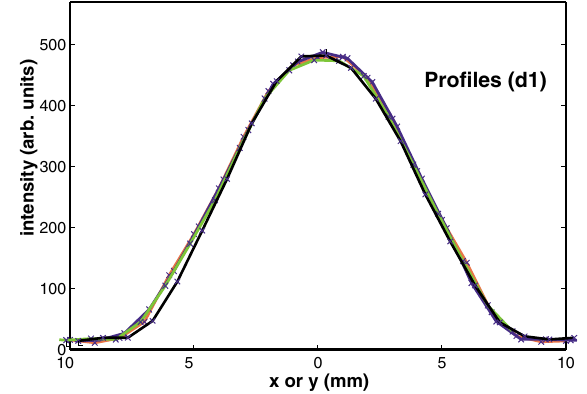
FIG. 3. (Color) Transverse beam profiles measured at the d 1 diagnostic station. The rms beam radii are identical to within (cid:9) 0 : 2 mm